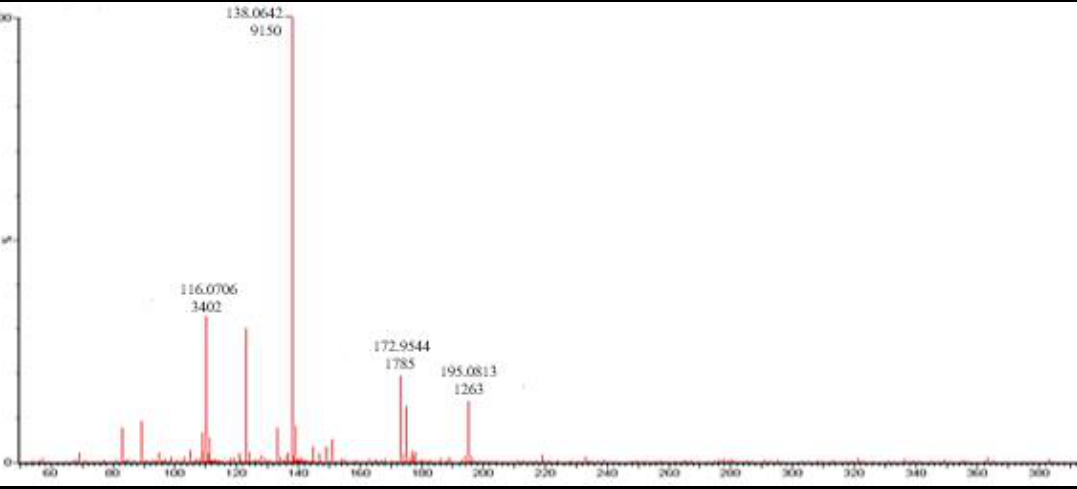
Figure 5. The spectrum of caffeine standard. Positive ion mode of Time-of-flight mass spectrometry electrospray ionization (TOF MS ESI+). Ion fragmentation m/z